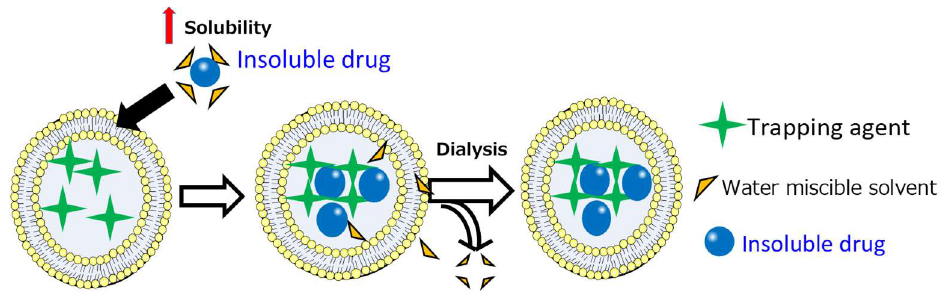
Figure 2. Solvent-assisted active loading technology (SALT) mechanism overview for liposomal loading of a poorly water-soluble drug.